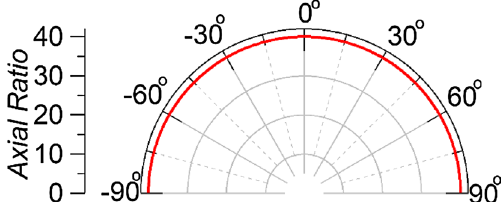
Figure 10. Axial ratio for the open-ended waveguide at 2.45 GHz.